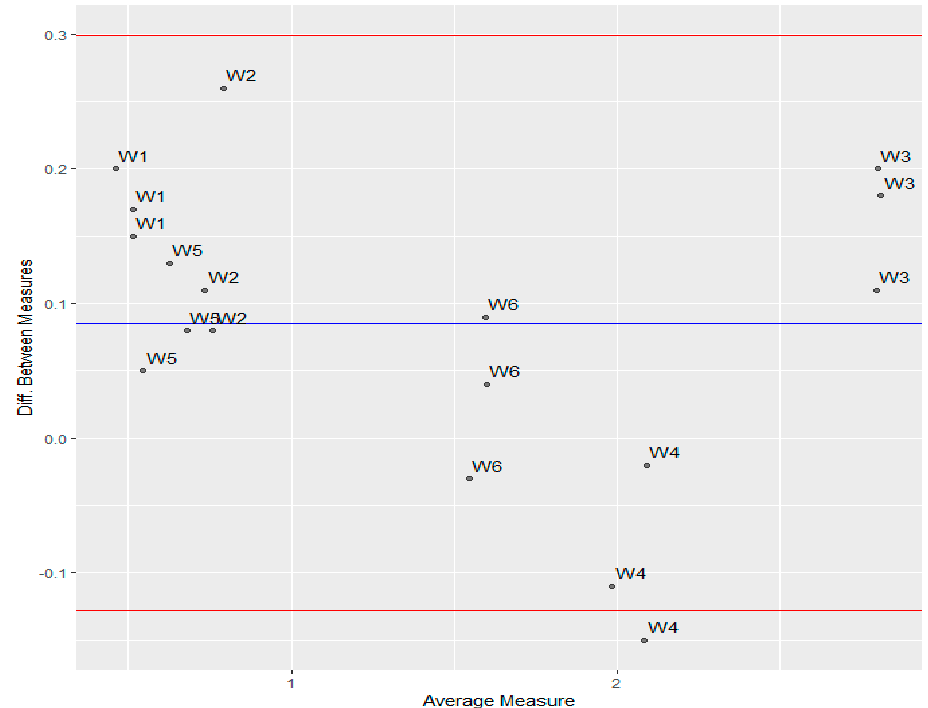
Figure 4. Bland-Altman plot of comparison of two methods (IAM-HLPC and ICP.MS). Blue line represents the mean of differences and red lines are lower and upper bounds of 95% confidence interval for the mean value.